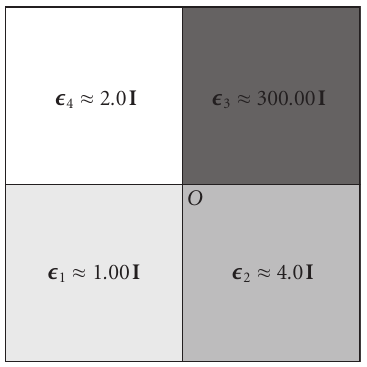
Figure 4.15 . Example 4.4: property distribution in Ω = ( − 1,1) × ( −